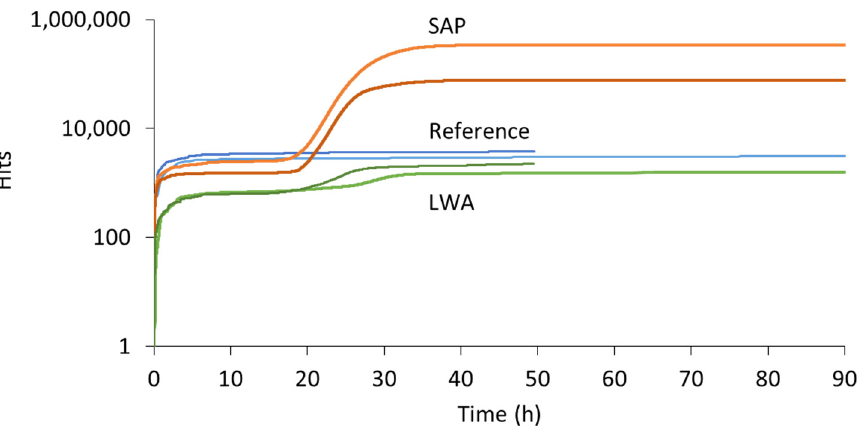
Figure 3. Cumulative hits vs. curing time received during AE monitoring of reference (= blue), SAP (= orange) and LWA (= green) cement paste.